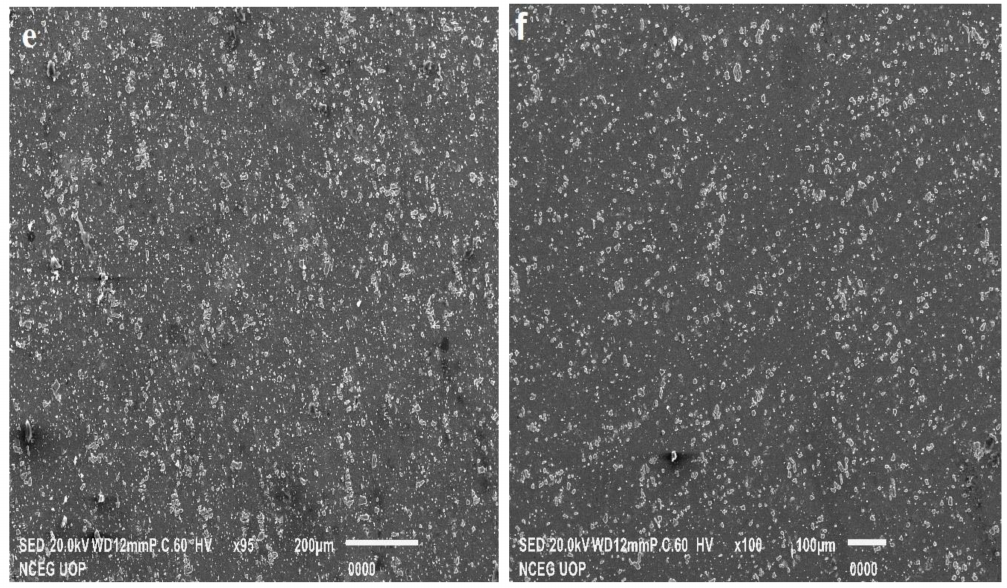
Figure 11. SEM image of ( a ) T6-2000, ( b ) A-2000, ( c ) T6-50, ( d ) A-50, ( e ) T6 blank and ( f ) annealed blank.